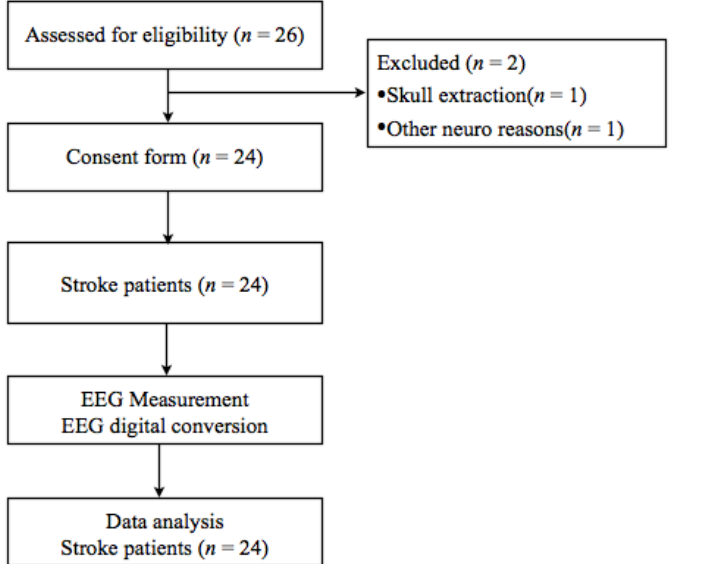
Figure 1. Electroencephalography (EEG) Experimental procedure.